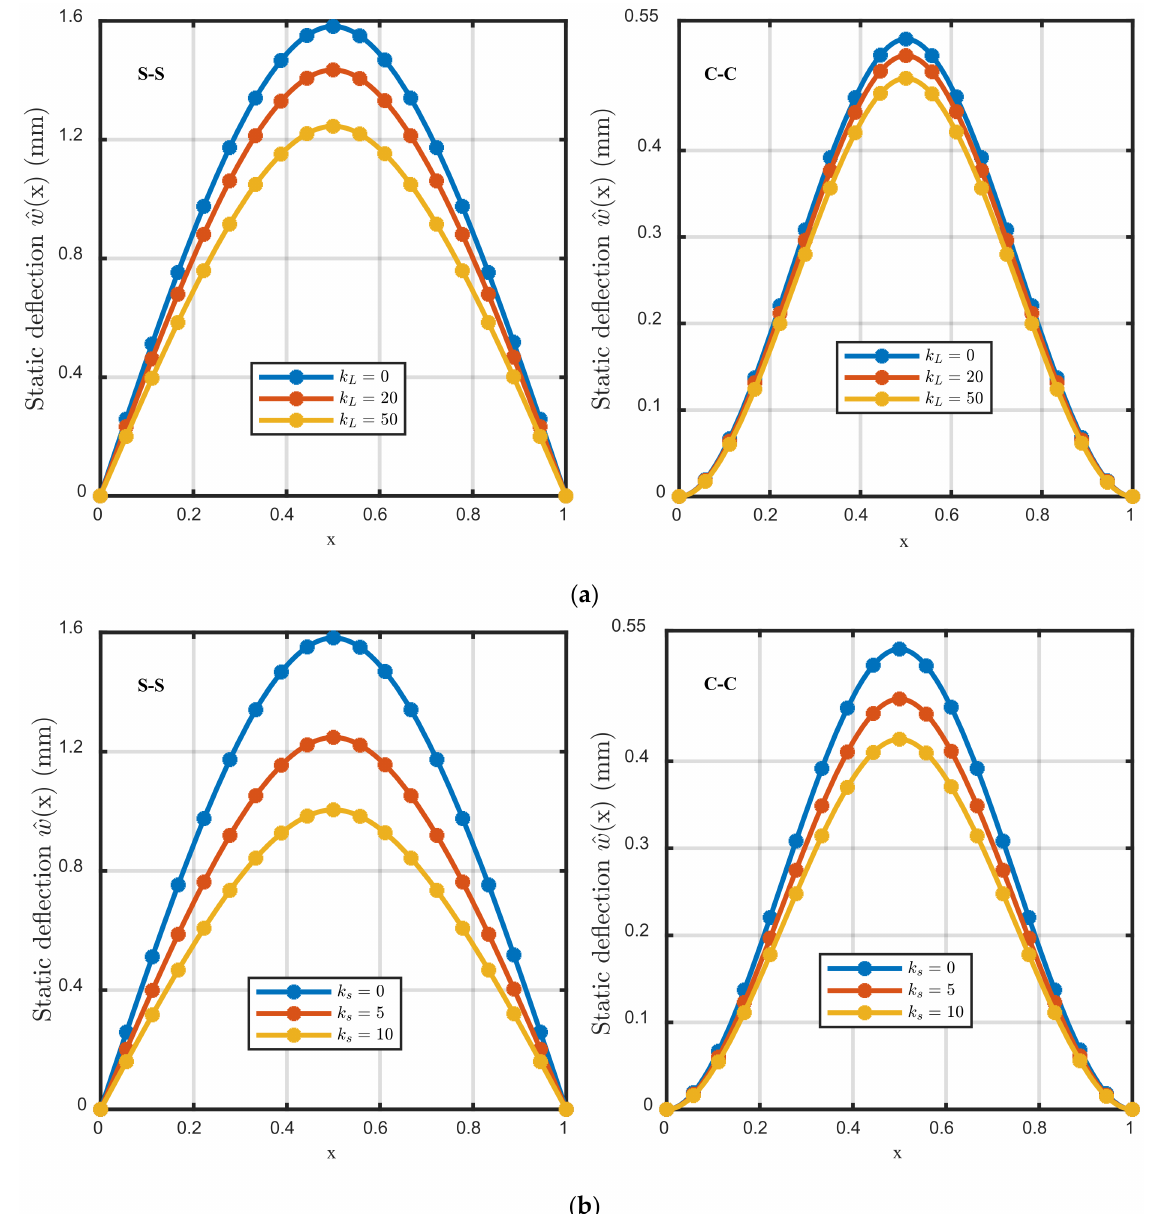
Figure 5. The bending deflection of imperfect S–S and C–C composite beams subjected to point load with layup sequence 3H ( L = 100 h , x 0 = 0.5, A 0 = 0, ˆ q 0 = 5 N ) . ( a ) k s = 0. ( b ) k L =